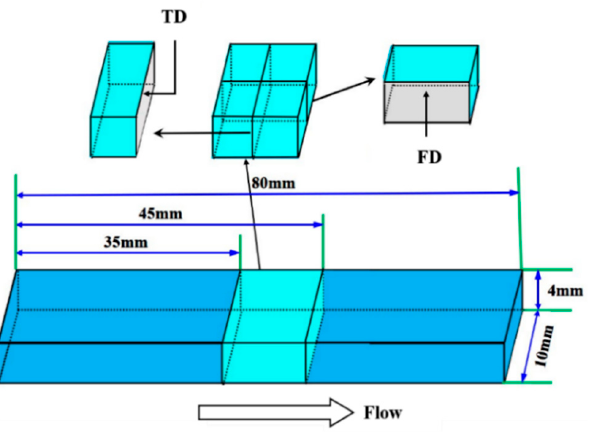
Figure 2. The geometry of impact specimen and characterization areas. FD, flow direction; TD, thickness direction.